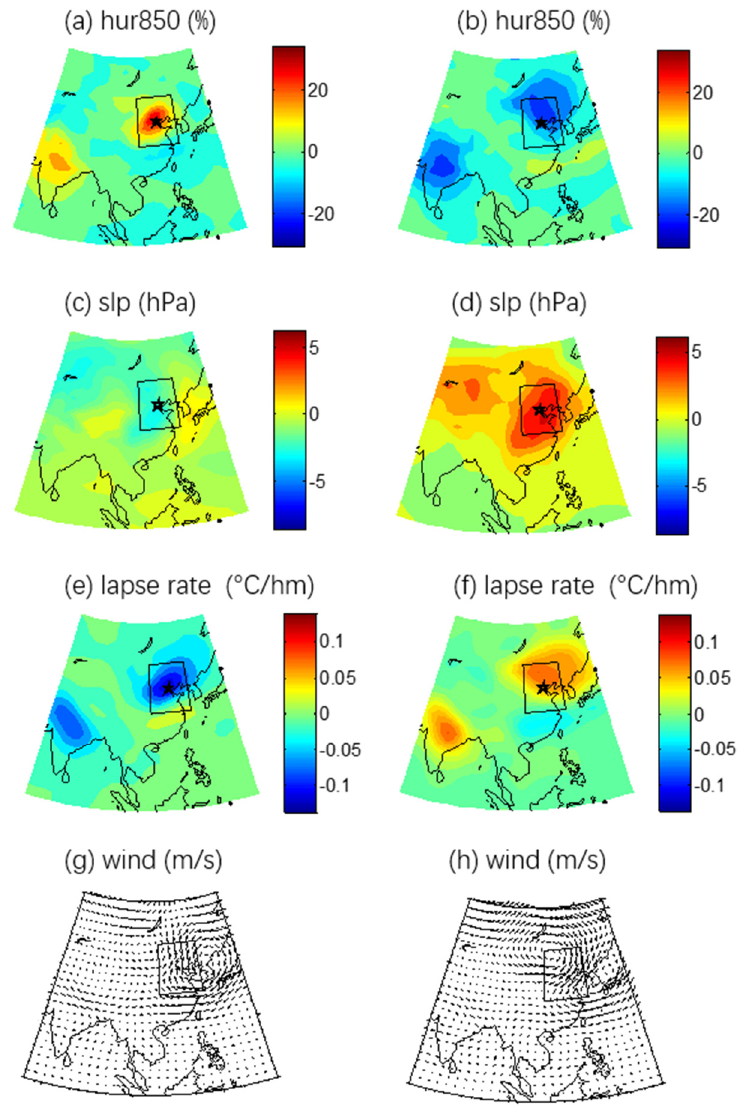
Figure 11. Comparison of the distribution states of each predictor in the wet and dry nodes at the Beijing station (where the left column figures are the distance level fields of each predictor in the wet nodes and the right column figures are the distance level fields of each predictor in the dry nodes).